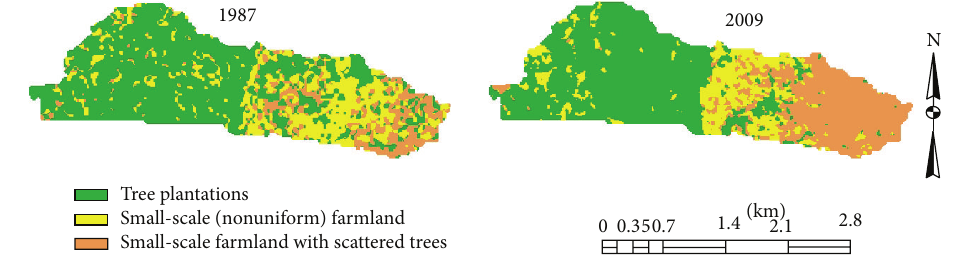
Figure 2: Land-use/cover distribution in Gataraga benchmarked watershed (Rwanda).